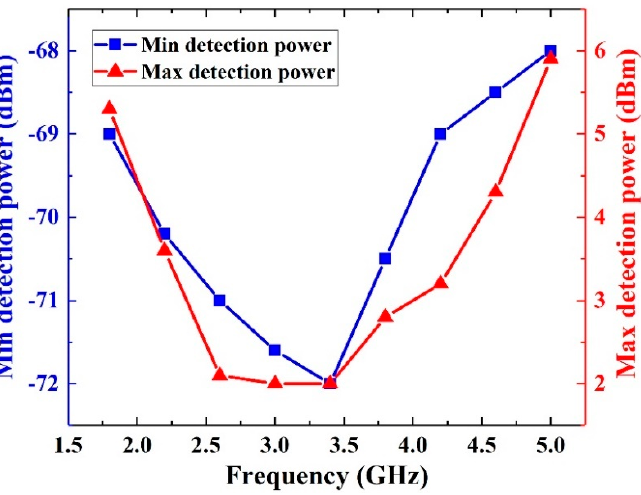
Figure 12. Dynamic range of the detection system.